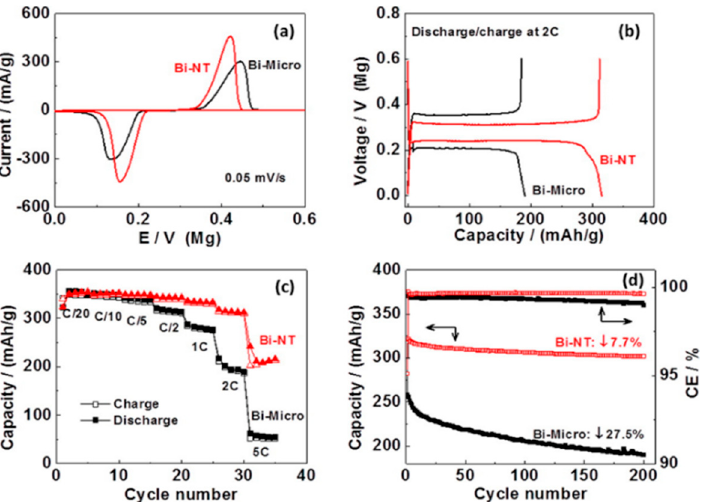
Figure 7. Electrochemical performances of bismuth NTs as anodes for MIBs: ( a ) Cyclic voltammo- grams (CV) of magnesium ions insertion/deinsertion; ( b ) Discharge/charge profile of a cell; ( c ) Rate performance of a cell; ( d ) Cycling stability and Coulombic efficiency of bismuth NTs for reversible magnesium ions insertion/deinsertion (C-rate was not reported by the authors). Cell con- figuration: Mg/Mg(BH 4 ) 2 0.1 M + LiBH 4 1.5 M in diglyme/Bi. A comparison with the corresponding microstructured anodes is also shown in each plot. Adapted with permission from [161]. Copyright American Chemical Society, 2014.